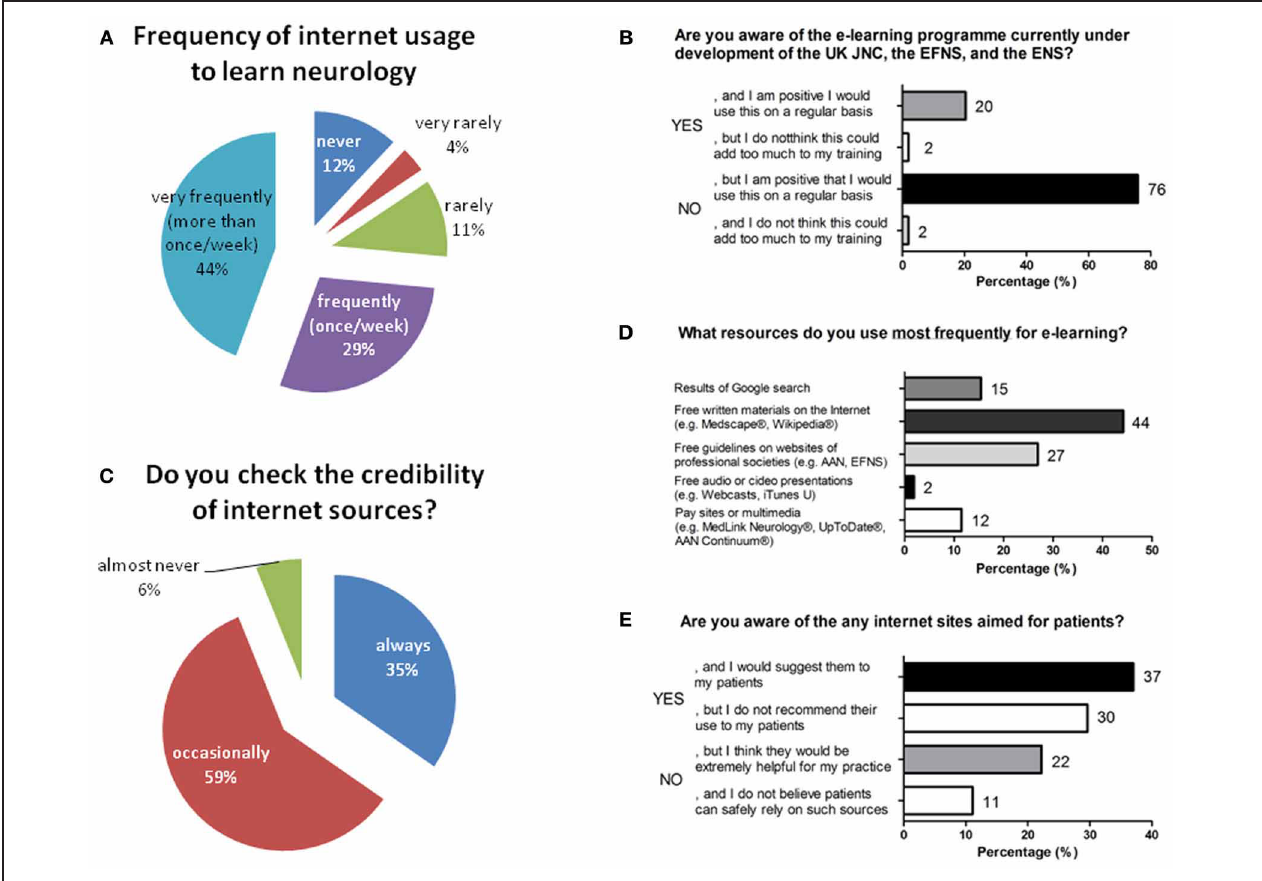
FIGURE 1 | Current e-learning preferences of 70 European junior neurologists. (A) Frequency of internet usage to learn neurology. (B) Awareness for e-brain, the e-learning platform under development of the